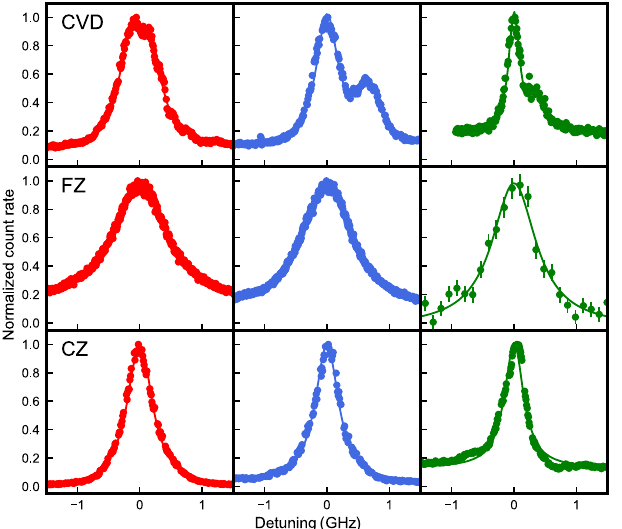
FIG. 10. Inhomogeneous linewidth comparison. The narrowest lines are obtained in the CZ samples. The FZ samples show an increased linewidth that is attributed to an increased crystal damage caused by the higher implantation energy. The CVD samples show a double-peak structure, which we attribute to the two implanted isotopes.